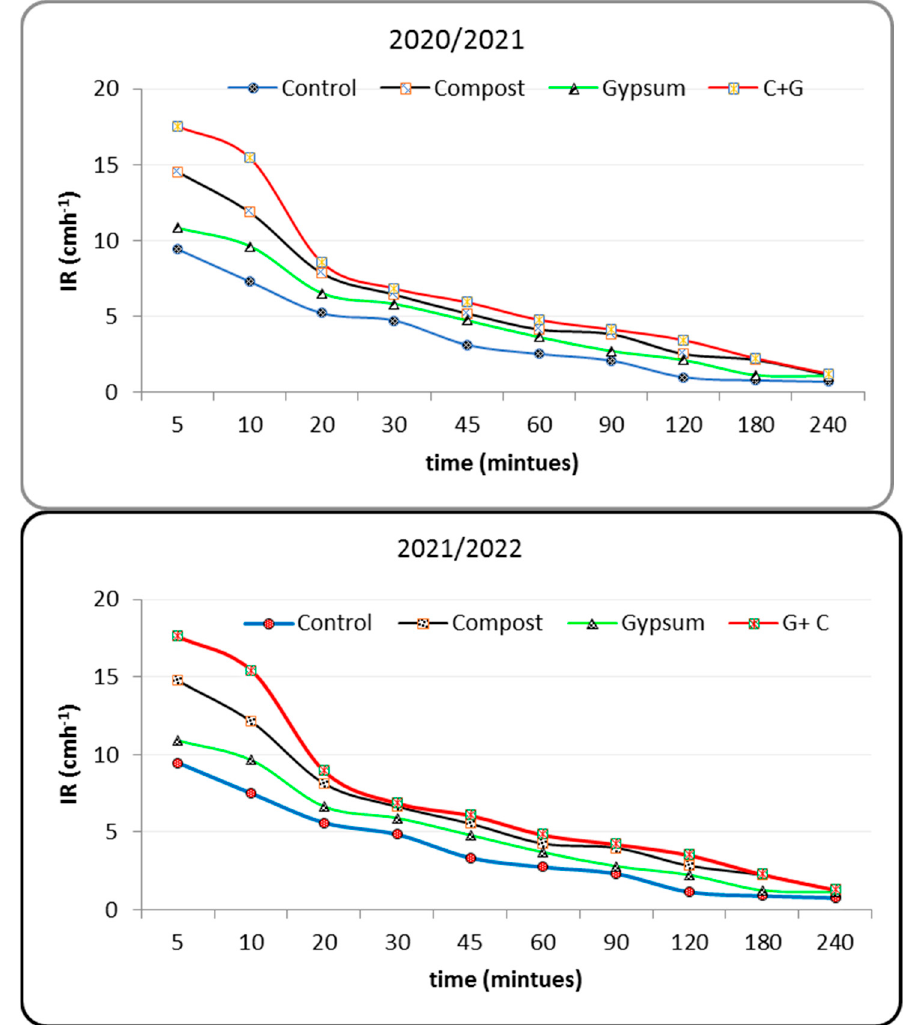
Figure 2 . Effect of soil amendments of gypsum and compost on soil basic infiltration rate (IR) in the 2020/2021 and 2021/2022 seasons.